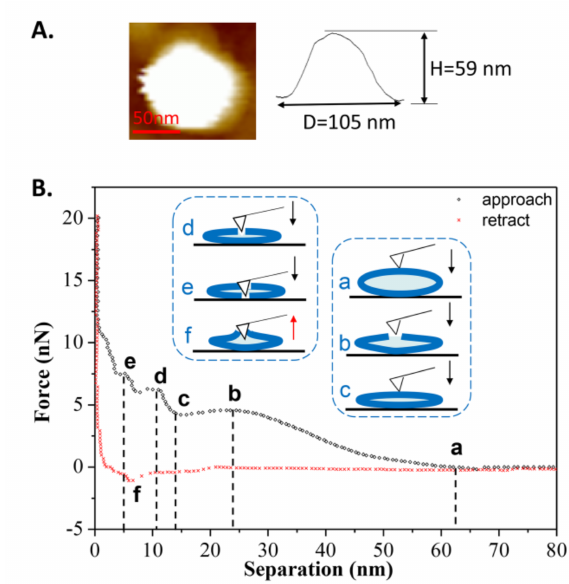
Figure 3. ( A ) AFM image of the vesicle prior to the first approach; ( B ) The force-distance curve and the schematic procedures describing the first tip approach and retraction on the DPPC vesicle obtained at T 1 = 60 ◦ C. The six states used in this whole article are described as follows: state a is the first contact when the tip approaches the spherical vesicle; state b is the appearance of a defect on the lipid membrane (water flows out of the defect); state c is the contact when the tip approaches close to the double-bilayer vesicle; state d is the tip penetration of the upper bilayer; state e is the tip penetration of the lower bilayer; and state f is the maximum adhesion during the retraction of the tip.